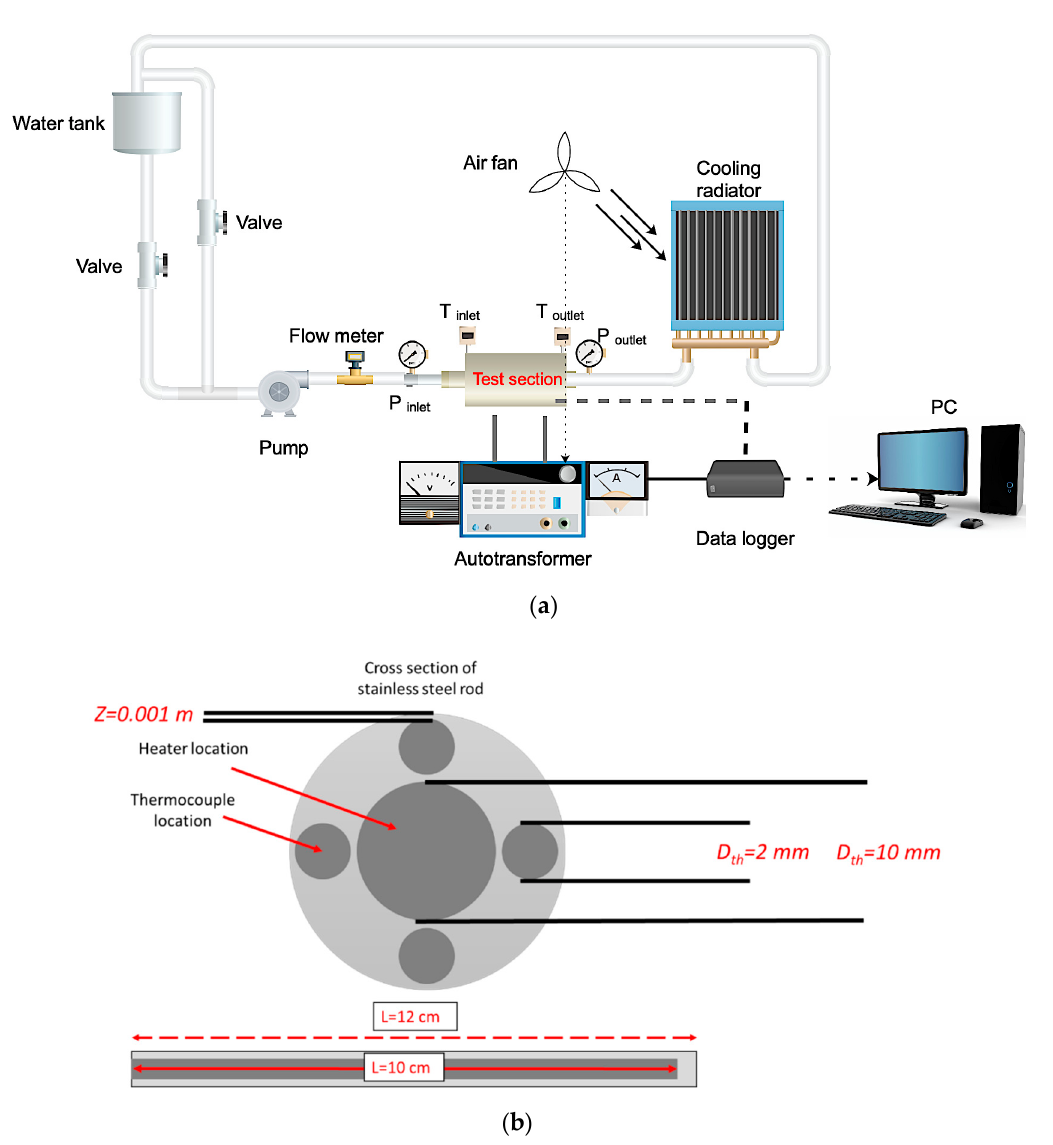
Figure 1. ( a ) Test setup and ( b ) detailed specifications of the stainless steel rod used as the heating